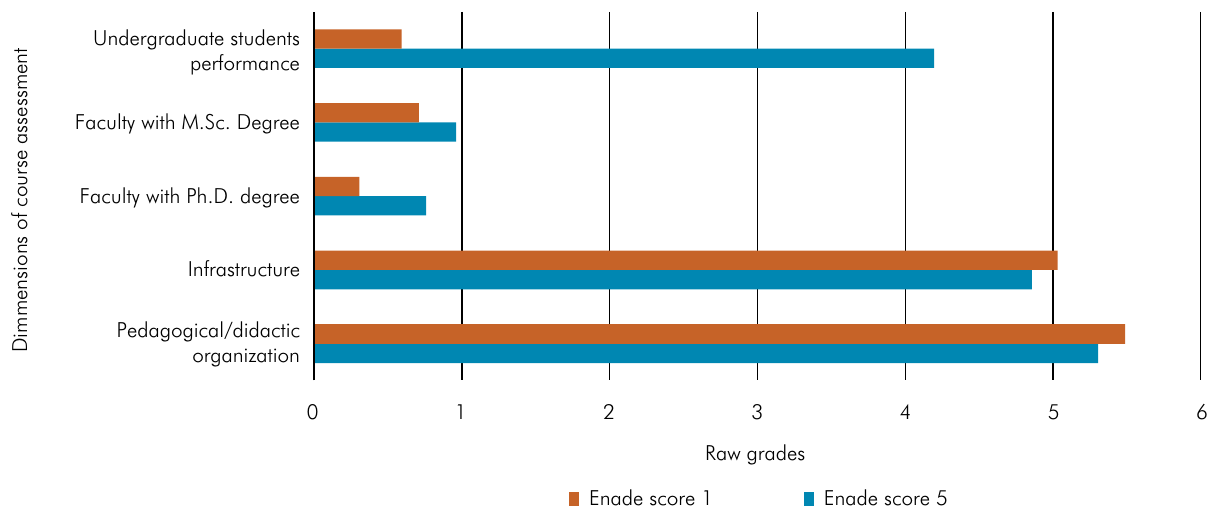
Figure 7. Comparative raw grades of IES with Enade scores 5 and 1 in the different dimensions of course assessment, obtained from 2016 INEP. 12